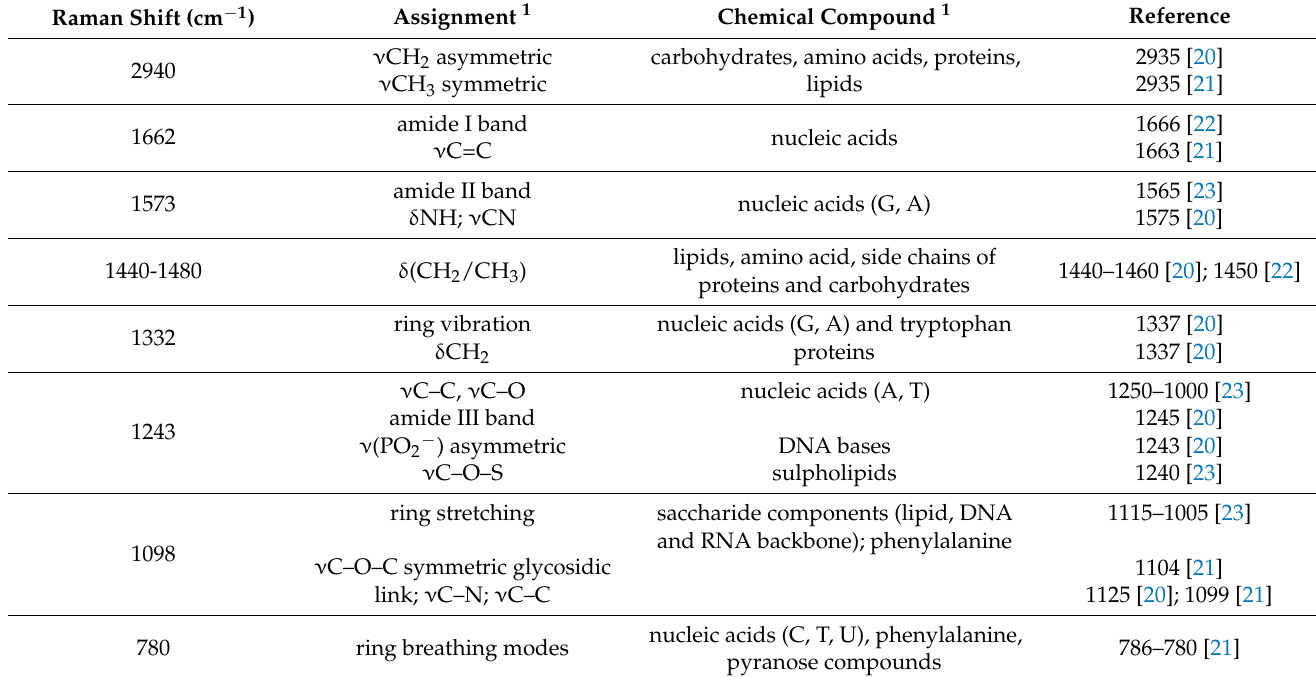
Table 1. Raman bands assignments to functional groups and corresponding